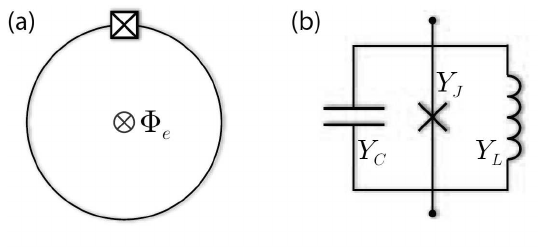
Figure 2: (from Ref. [ 10 ] ) (a) Schematic representation of a qubit controlled by